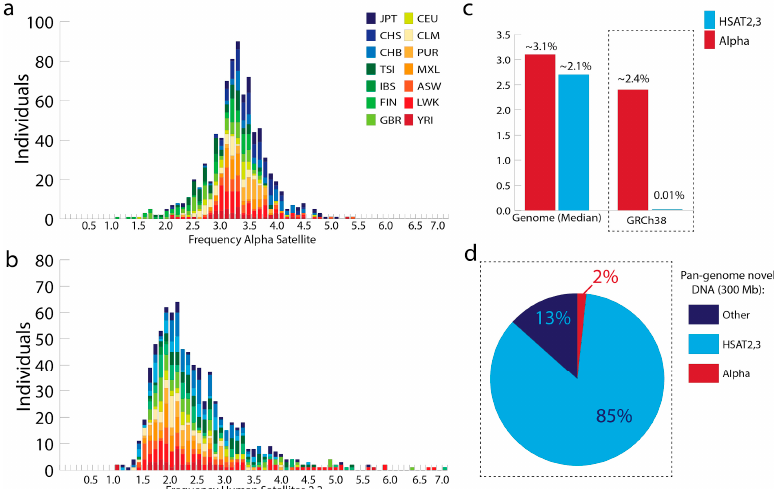
Figure 1. Proportion of alpha satellite and human satellites 2,3 in the human population. Using 1KG [1] data representing 14 diverse populations (400 male individuals and 414 female individuals) (a) the frequency of 24-mers that have an exact match with alpha satellite [23], (b) the frequency of 24-mers that have an exact match with human satellite 2,3 [31]. (c) Median frequencies (from panel (a) alpha and (b) HSat2,3) are listed relative to the observed frequency in the human reference genome assembly (GRCh38; GCA_000001405.15). (d) Evaluation of 300 Mb of DNA from the collective genomes of 910 people of African descent, previously determined to be missing or unaligned to GRCh38